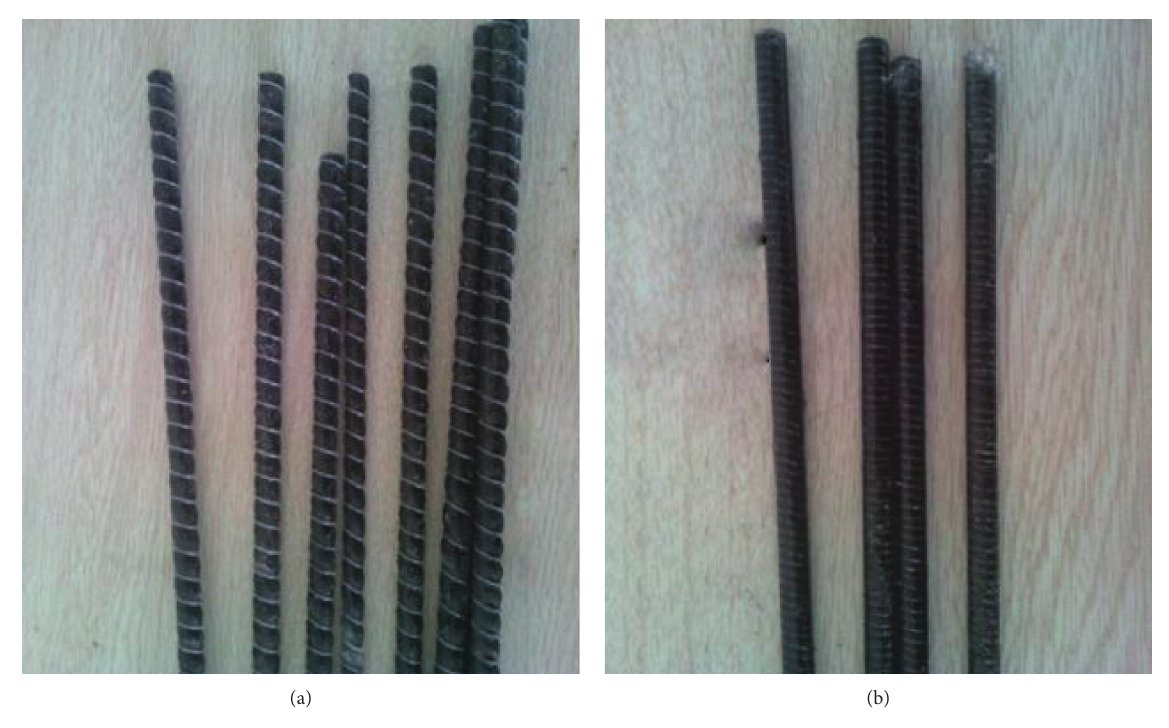
Figure 2: FRP bars [93]: (a) GFRP bars; (b) BFRP